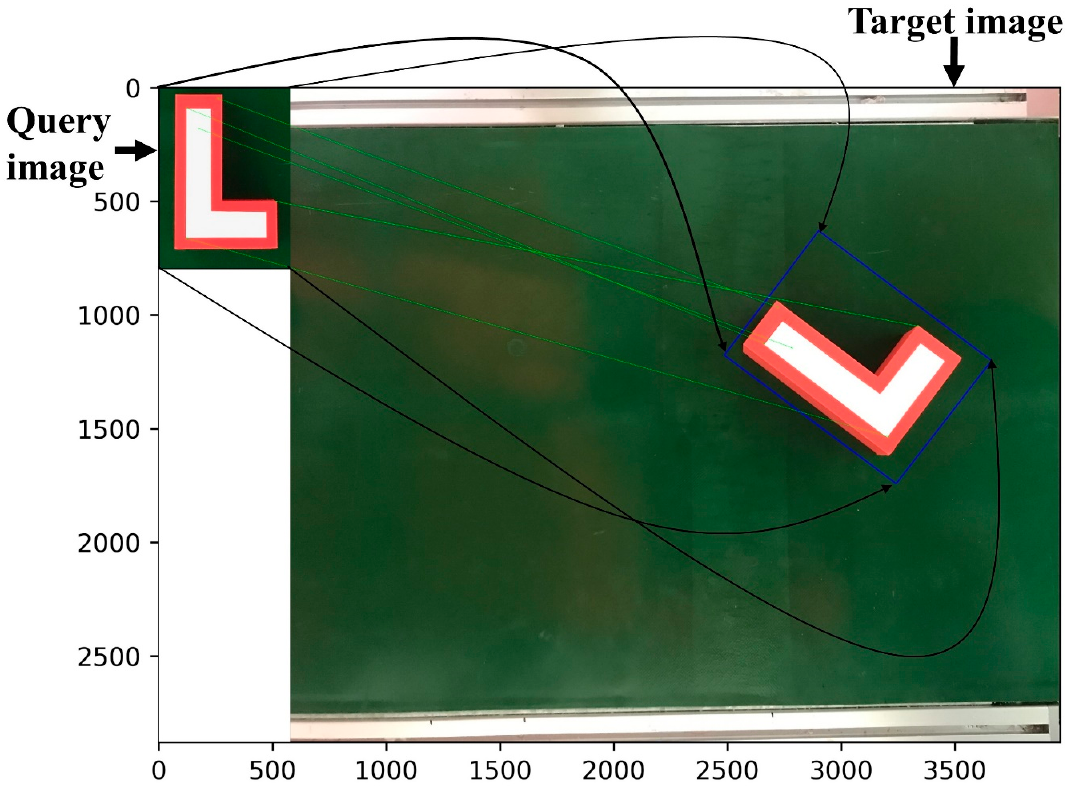
Figure 14. Overall results of the proposed technique on a nonrectangular object.